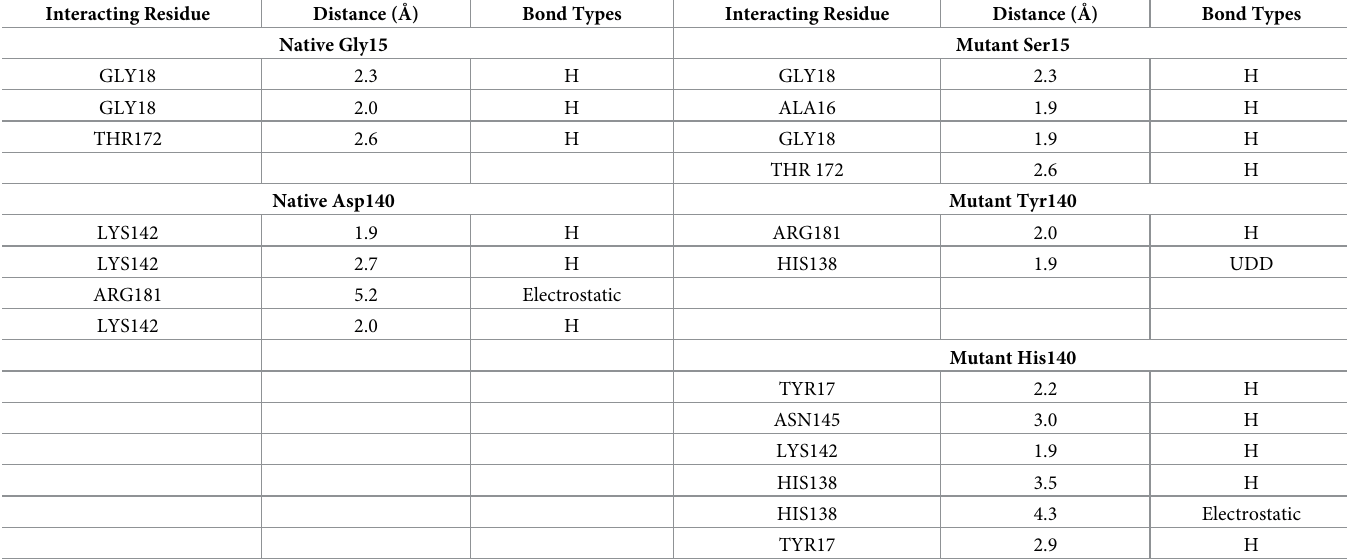
Table 4. Non bond interaction analysis of native and mutated residues with surrounding residues (UDD = Unfavorable Donor-Donor clash). Interacting